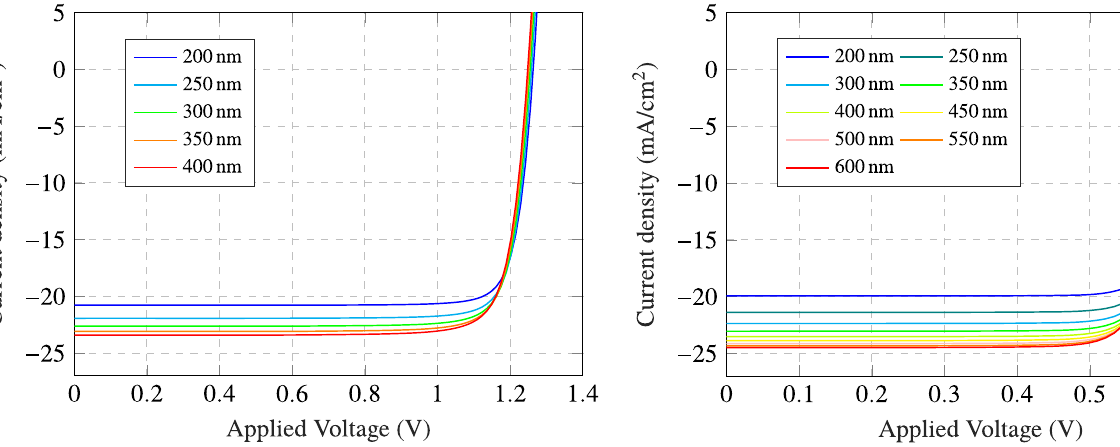
Fig. 3. Simulated J – V characteristics for top cells with varying perovskite thickness. The perovskite bandgap is fi xed to 1.55eV.